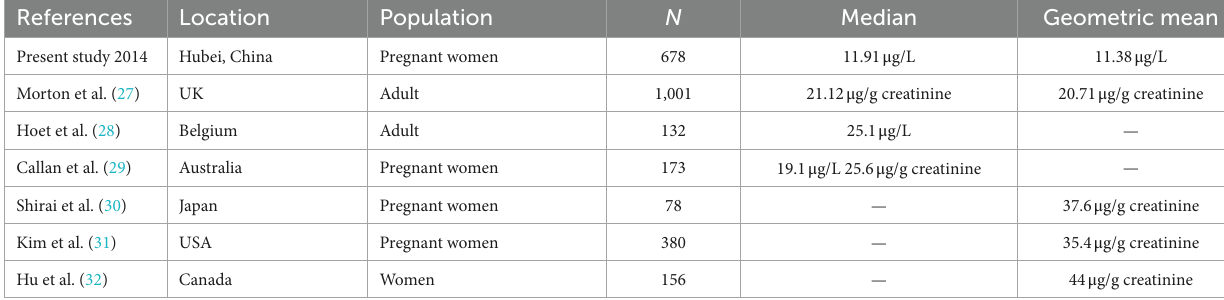
TABLE 4 Comparison of Se levels in urine between the present study and previous